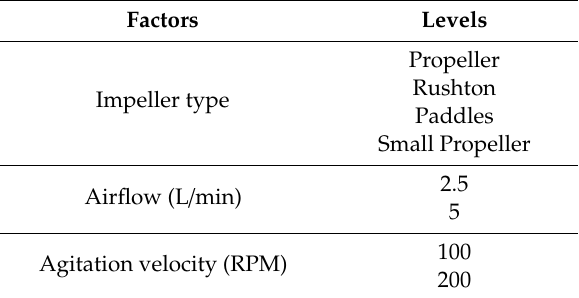
Table 2. Experimental design to determine k L a